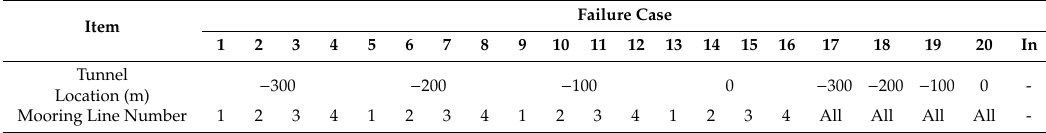
Table 2. Mooring-failure scenarios (mooring line number is based on the line number in Figure 1b, In = intact case, All = failure of all mooring lines (# 1, 2, 3, and 4) at their tunnel location).